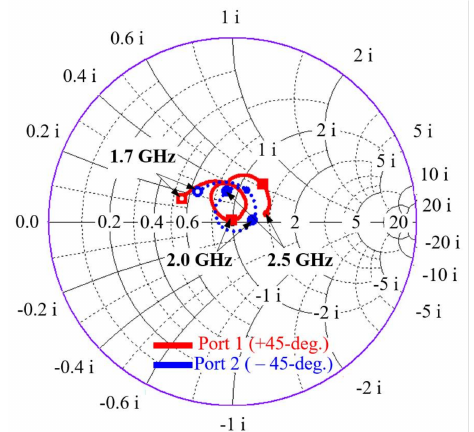
Figure 3. Simulated input impedance curves at different frequency points of the two dipoles.